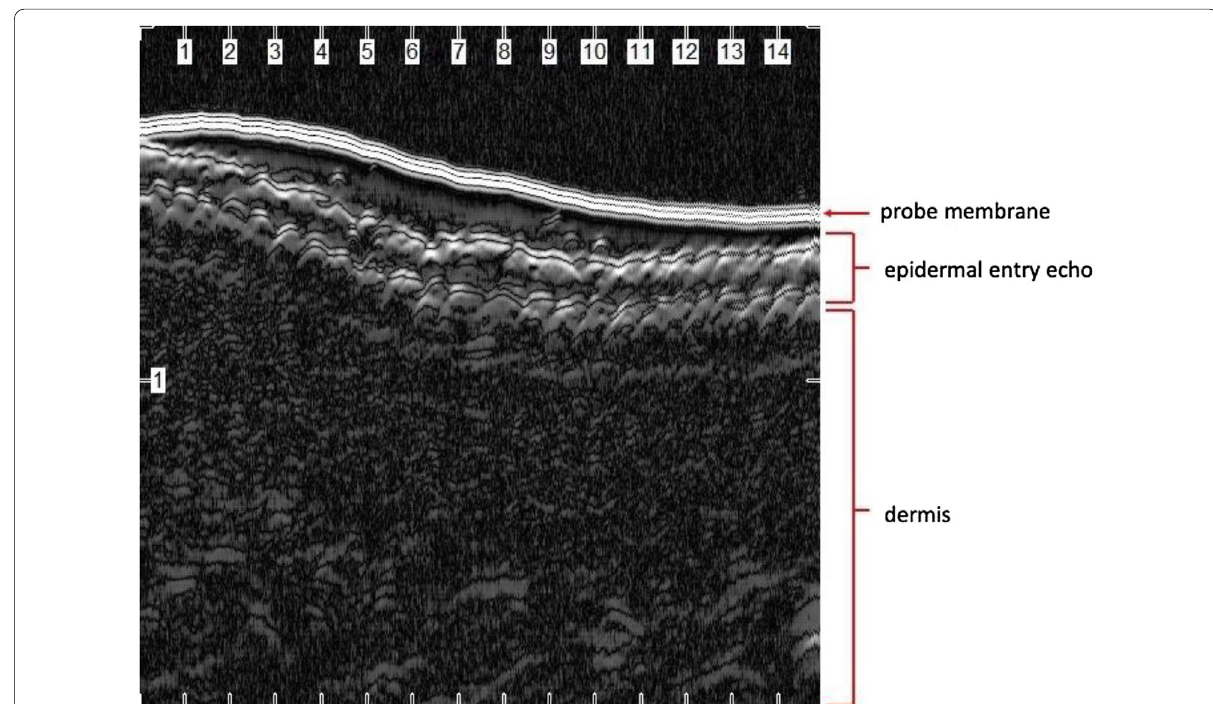
Fig. 2 Glabrous skin from the palm using a 50-MHz HFUS probe (Longport, Inc. EPISCAN). Note the bilaminar hyperechoic entry echo due to the thickened stratum corneum in this anatomic location